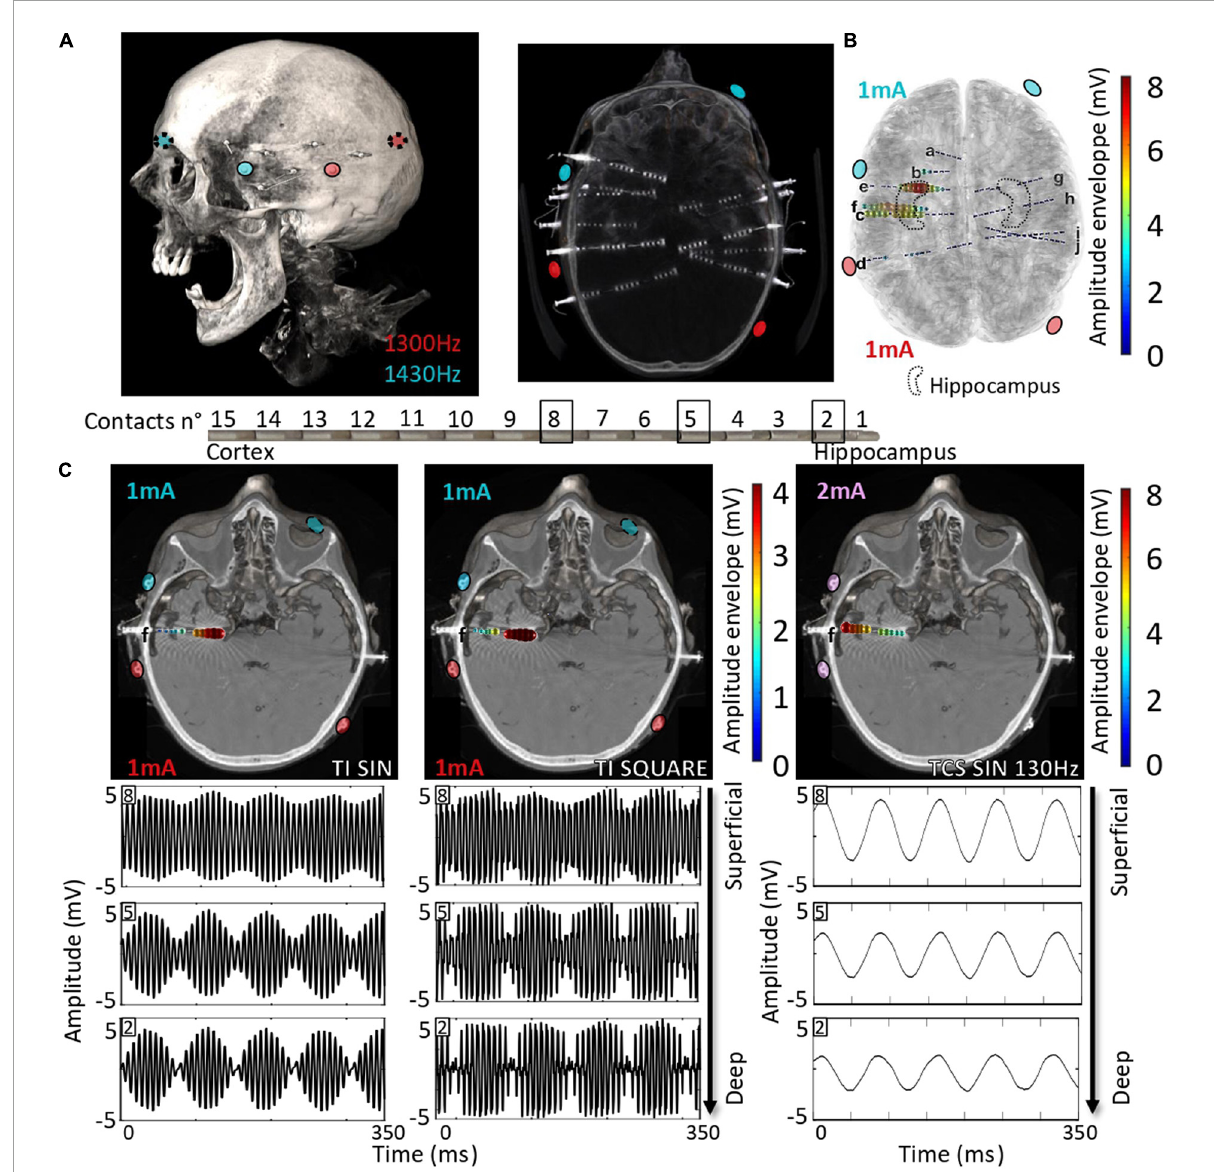
FIGURE4 Scaling the effect of TI-HFS at 130 Hz in the human head. (A) . Placement of electrodes on the skin of the human cadaver. About 10 SEEGs were implanted in the brain for MTLE patients to record the stimulation potentials inside the brain. (B) Co-registration with the scanner and a template MRI show the amplitude of the envelope recorded during the TI-HFS session. It gives an indication on where the focus of stimulation is and the amplitude of the envelope of stimulation. Here, 1 and 3 mA were chosen to better target the anterior hippocampus in this specific cadaver and the field modulation envelope can reach an amplitude of 7 mV. (C) Electrode f is used to show the depth of the focal stimulation of TI-HFS in both square and sine waves. For TCS-like 130 Hz, it shows stronger stimulating fields in the cortex, which is primarily activated, compared to the deep structures, unlike for TI with sine waves or square waves (PWM